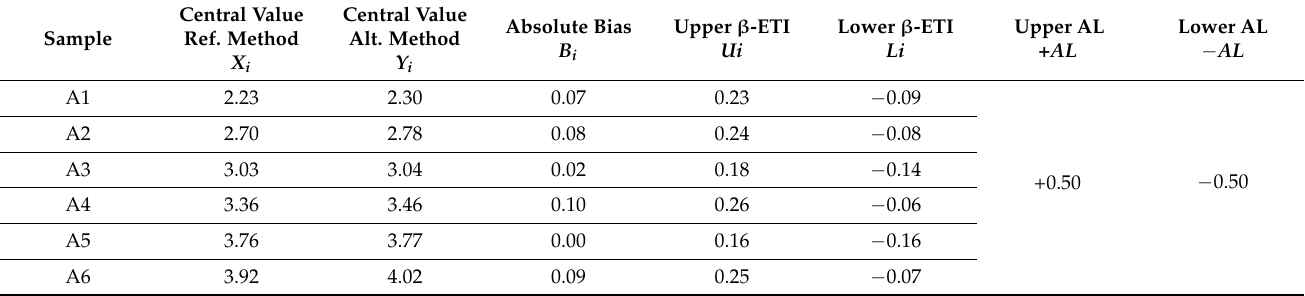
Table 7. Results of the accuracy profile study on chicken neck skin for C. coli [log 10 live counts/mL].